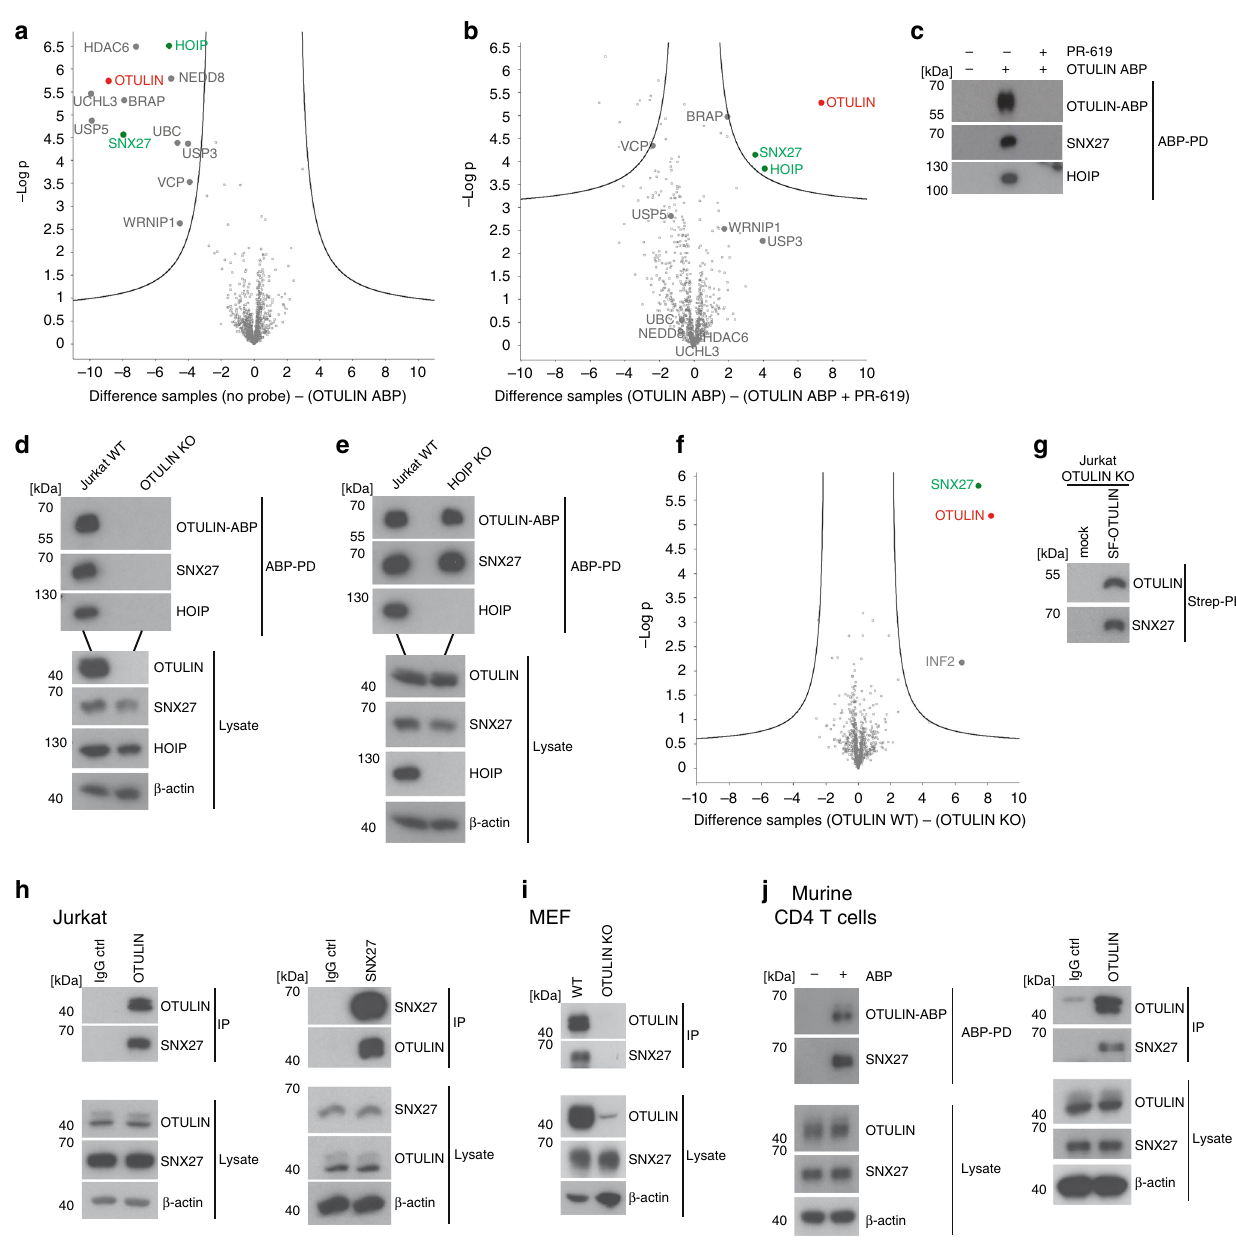
Fig. 1 Identi fi cation of SNX27 as an OTULIN interactor. a Selective protein enrichment after OTULIN ABP-PD. Volcano plot illustrating the enrichment of proteins identi fi ed by LC-MS/MS after PD in the presence or absence of OTULIN ABP. Curves depict signi fi cant enrichment or depletion, respectively. b Selective depletion of proteins from OTULIN ABP by PR-619 treatment. Volcano plot demonstrates loss of protein binding in samples treated with PR-619 before OTULIN ABP incubation and PD. Curves depict signi fi cant enrichment or depletion, respectively. c OTULIN-ABP PD was performed under conditions used for LC-MS/MS and binding of HOIP and SNX27 was analyzed by WB. d OTULIN ABP-PD was performed from extracts of parental or OTULIN KO Jurkat T cells. Co-precipitation of HOIP and SNX27 was analyzed by WB. e OTULIN ABP-PD was performed from extracts of parental or HOIP KO Jurkat T cells. Co-precipitation of HOIP and SNX27 was analyzed by WB. f Enrichment of proteins by PD of SF-OTULIN. Volcano plot depicts signi fi cant enrichment of proteins after Strep-PD from extracts of OTULIN-de fi cient Jurkat T cells expressing SF-OTULIN or mock control. Curves depict signi fi cant enrichment or depletion, respectively. g OTULIN-SNX27 interaction in reconstituted OTULIN KO Jurkat T cells was analyzed by WB after Strep-PD. h OTULIN-IP and SNX27-IP from extracts of Jurkat T cells. Rabbit or mouse IgG antibodies were used as isotype controls and protein binding was analyzed by WB. i OTULIN-IP from extracts of WT and OTULIN KO MEFs. Co-immunoprecipitation of SNX27 was analyzed by WB. j ABP-PD (left) and OTULIN-IP (right) from murine primary CD4 T cell extracts. Rabbit IgG antibody was used as an isotype control. Interaction of SNX27 to murine OTULIN-ABP complex and OTULIN was assessed by WB. Source data are provided as a Source Data fi